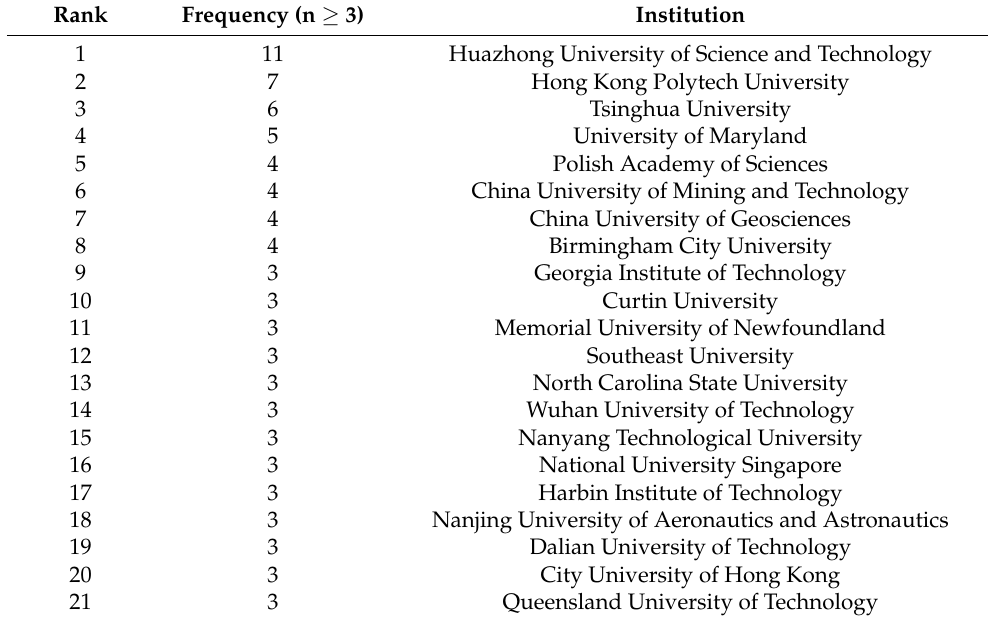
Table 2. Distribution of institutions (total number of articles: 119).